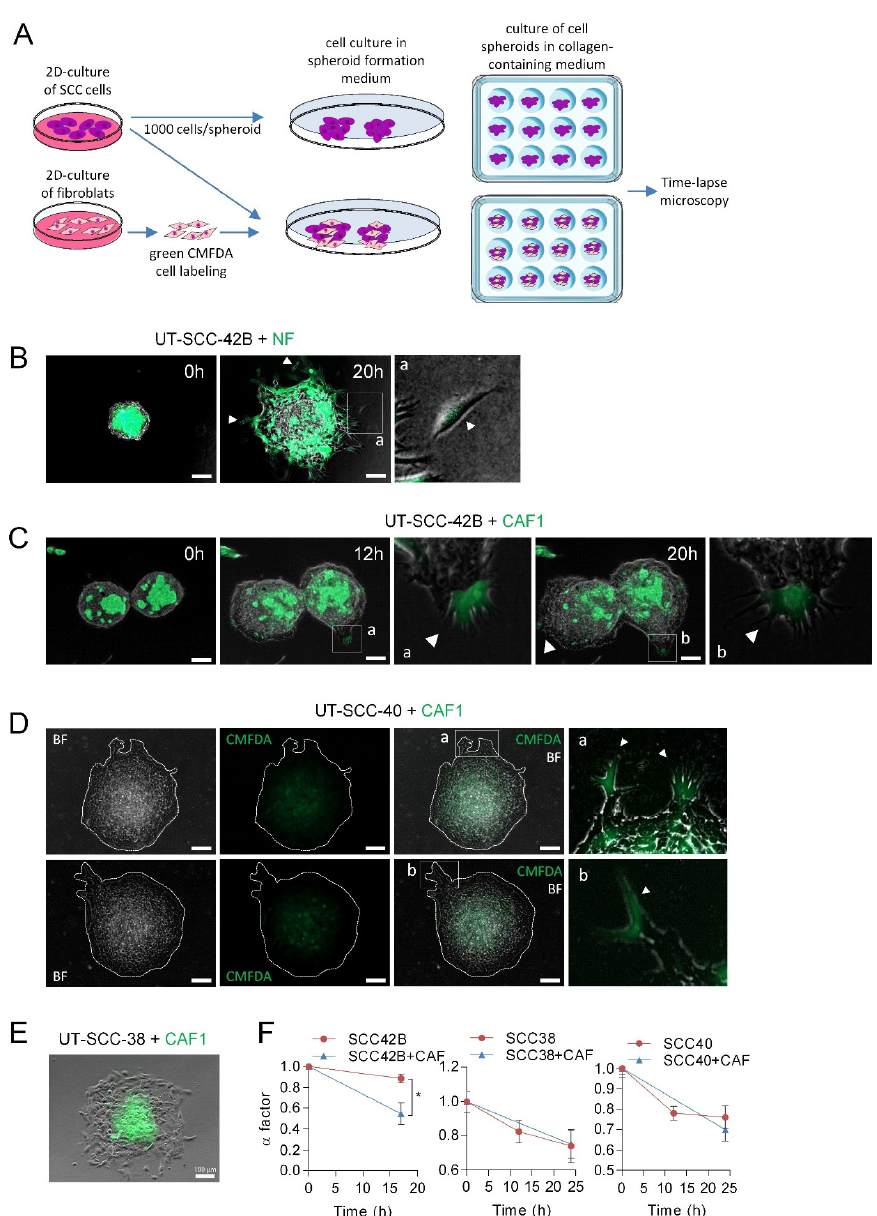
Figure 3. Leadership of CAFs in the invasive fronts of CAF + SCC mixed spheroids. ( A ) A scheme showing the protocol for assembly of SCC or SCC + CAF spheroids. Hanging drop cell cultures were done by using 1000 cells/spheroid, either SCC cells or CMFDA-labeled fibroblasts plus SCC cells (500 cells each), to form cell spheroids that were subsequently embedded in a collagen medium and time-lapse recorded. ( B – E ) Representative images of spheroids assembled with mixed populations of SCC cells and NF or CAF1 at the indicated times of incubation. Fibroblast-cell lines were labeled with green CMFDA to allow their tracking over time. Pictures a and b (panels B – D ) are magnified images of the indicated insets to highlight the presence of CMFDA-labeled fibroblasts. White arrows point to NF cells slipping away from the spheroid (panel B) and CAFs leading the invasive finger-like cell tracks in panels ( C , D ). Pictures in panel D are representative bright field (BF) and fluorescence (CMFDA) images of two mixed SCC + CAF spheroids that were allowed to migrate for 24 h. Dashed white lines show the limits of the spheroid. Scale bars: 100 µ m. ( F ) Variation over time of the α factor for the indicated cell spheroids. Data are presented as the mean value ± standard deviation from 3 experiments and 10–20 spheroids analyzed in each. * indicates p <